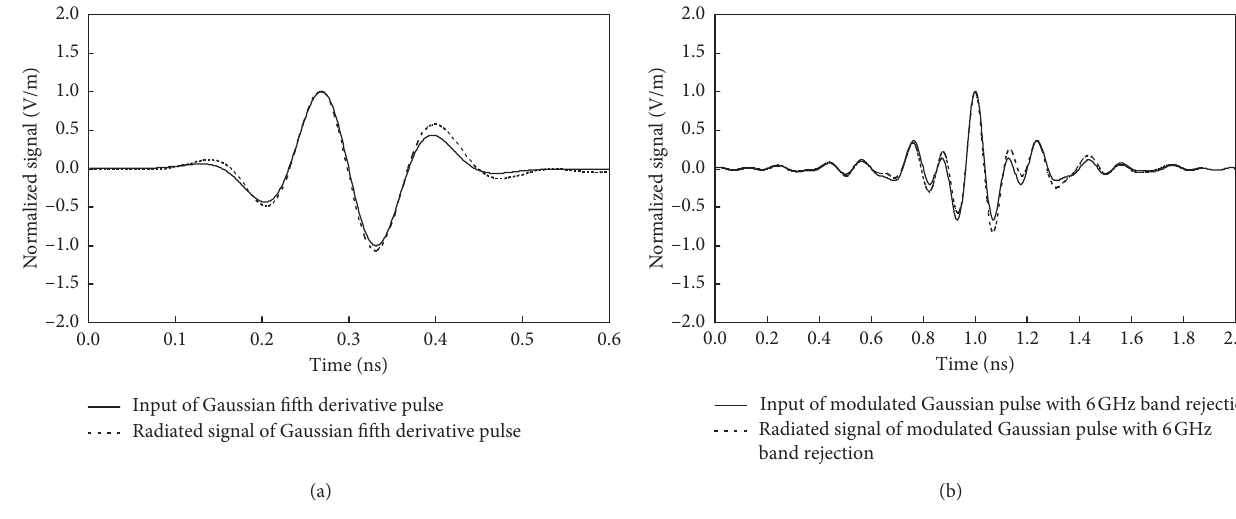
Figure 19: Waveforms of the input pulse superimposed on the radiated pulse. (a) Signals of the fifth-order derivative Gaussian pulse. (b) Signals of the modulated Gaussian pulse with 6GHz band